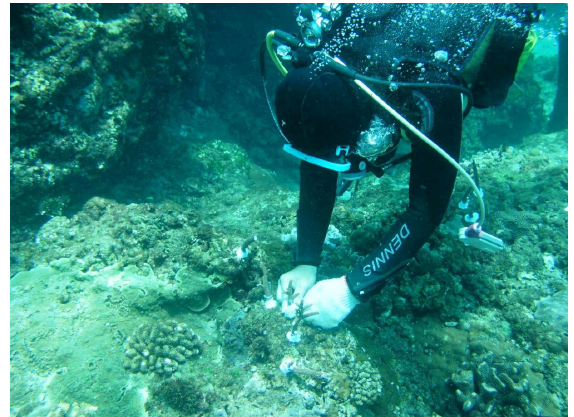
Figure 2. Diving and cleaning waste in Kenting National